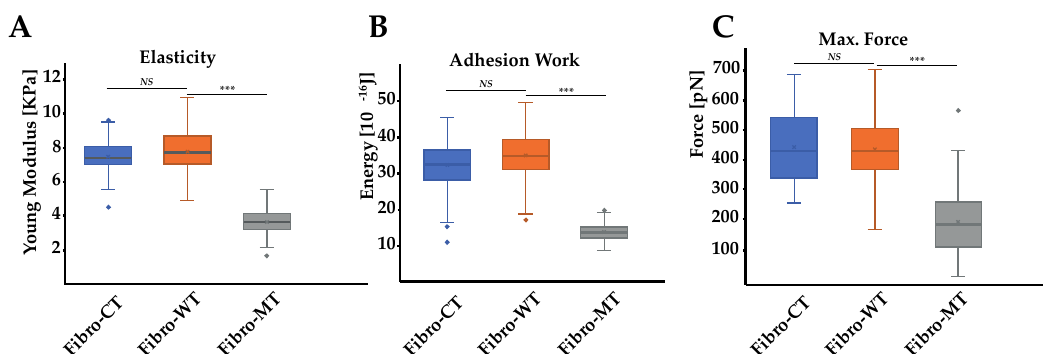
Figure 3. Biophysical properties of living NRVFs. ( A ) Comparison of elasticity (expressed as Young’s modulus) between NRVFs with the WT adenoviral infection (Fibro-CT), NRVFs wild type (Fibro-WT), and NRVFs with LMNA D192G mutation (Fibro-MT) (n Fibro-CT = 61, n Fibro-WT = 63, n Fibro-MT = 56 analyzed curves, respectively). ( B ) Cell–cell adhesion energy defined as the energy to separate two NRVFs. (n Fibro-CT = 152, n Fibro-WT = 221, n Fibro-MT = 177 analyzed curves, respectively). ( C ) Comparison of maximum force in cell–cell adhesion/de-adhesion expresses as the maximum force applied to separate two NRVFs, (n Fibro-CT = 152, n Fibro-WT = 221, n Fibro-MT = 177 analyzed curves, respectively), (*** p < 0.0001; * p < 0.05, NS = non-significant). Numerical data is divided into quartiles, and a box is drawn between the first and third quartiles, with an additional line drawn along the second quartile to mark the median. The minimums and maximums outside the first and third quartiles are depicted with lines.